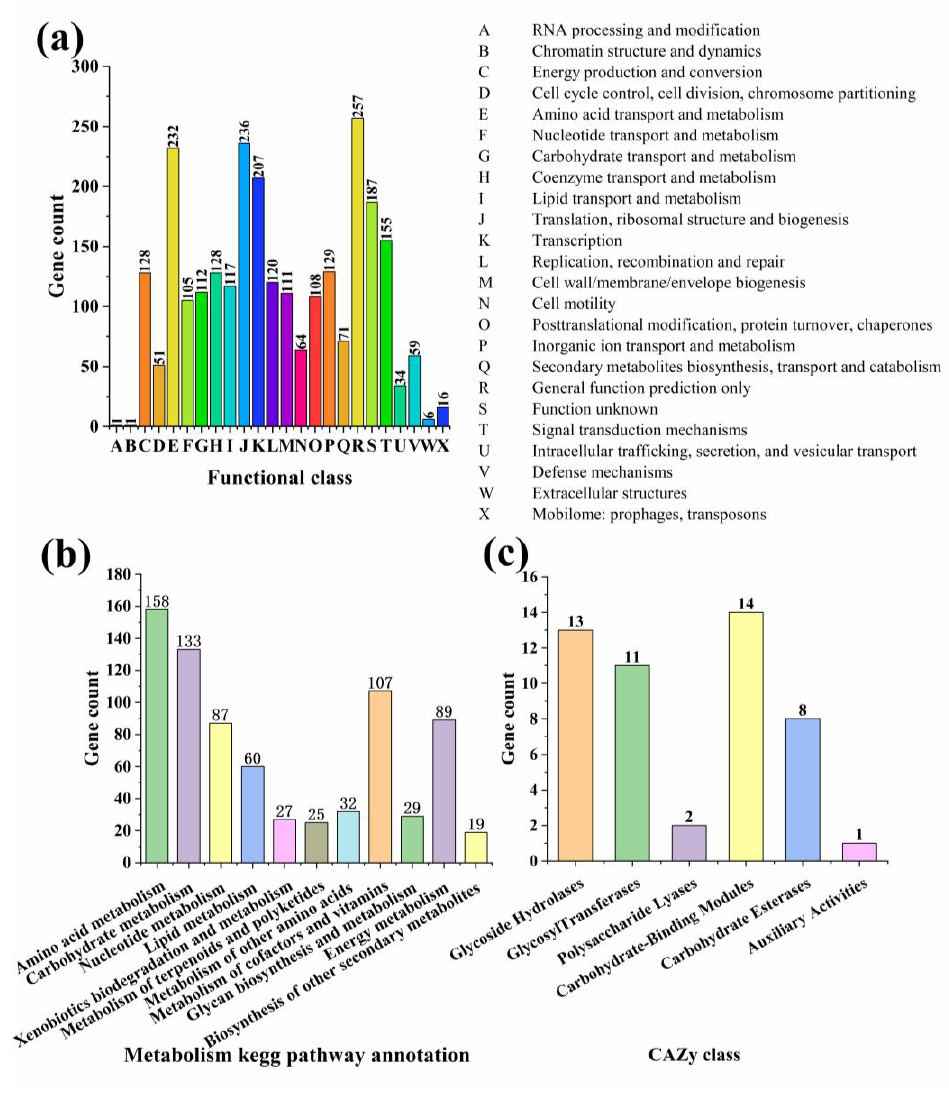
Figure 3. COG functional categories of strain Rummeliibacillus sp. TYF-LIM-RU47 ( a ), metabolism KEGG pathway annotation ( b ) and CAZy function classification ( c ).